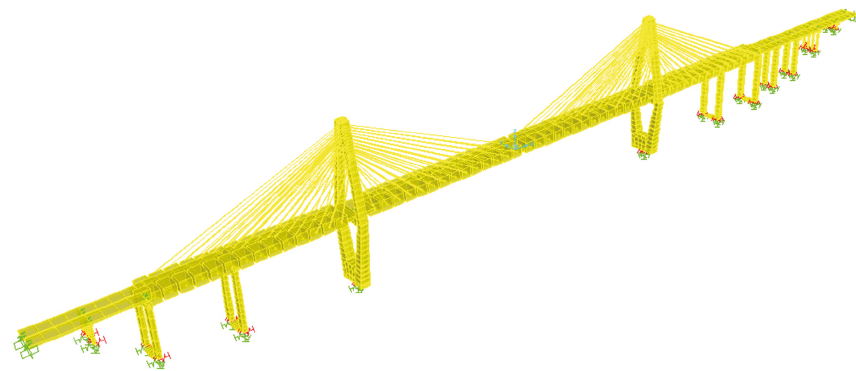
Figure 2: Finite element model of Xigu Yellow River Bridge.